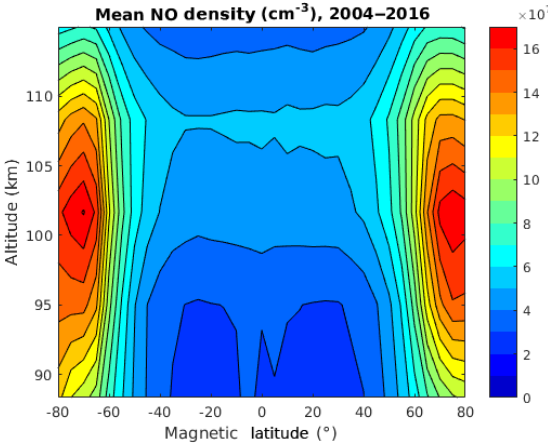
Figure 3. Mean NO density of NO measured by Odin SMR from 2004 to